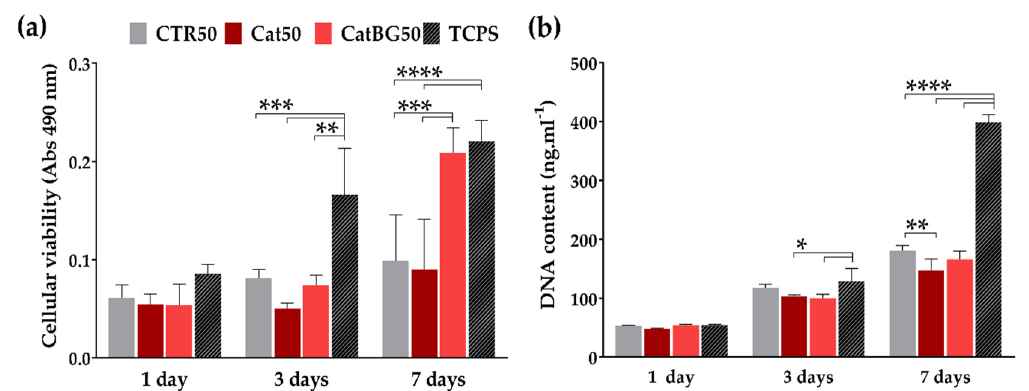
Figure 15. ( a ) Cellular viability analysis using the MTS assay and ( b ) DNA quantification using the PicoGreen assay, SaOs-2 cells cultured on the CTR50, Cat50, and CatBG50 films in D-MEM for 1, 3, and 7 days. Tissue culture polystyrene (TCPS) was used as control. Significant differences were found for p < 0.05 (*), p < 0.01 (**), p < 0.001 (***), and p < 0.0001 (****).